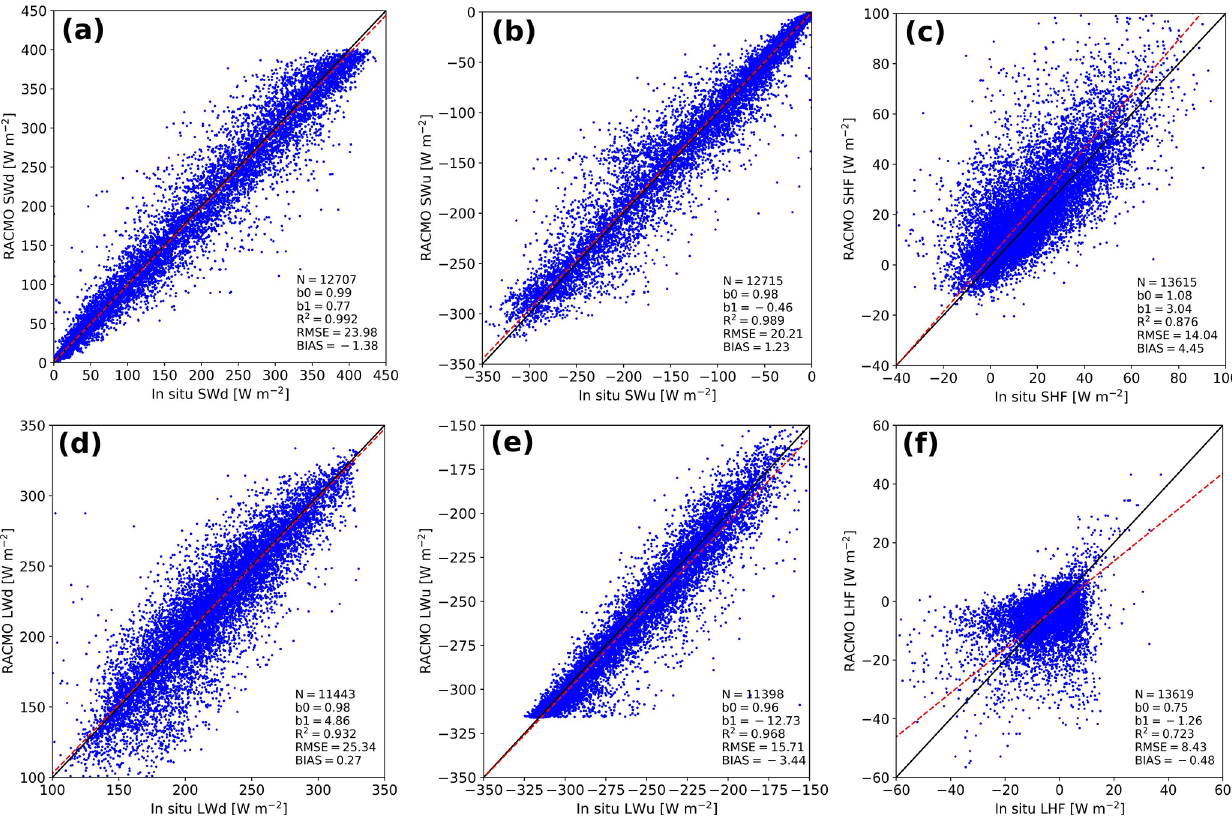
Figure 6. Daily-averaged Rp3 SEB components between 2006 and 2015 compared to in situ observations including S6, S9, and S10 of the K-transect and KAN-U and KAN-M of PROMICE for (a) downward shortwave radiation (SW d ), (b) upward shortwave radiation (SW u ), (c) sensible heat flux (SHF), (d) downward longwave radiation (LW d ), (e) upward longwave radiation (LW u ) and (f) latent heat flux (LHF). The black line is the one-to-one line, and the red line shows the orthogonal total least-squares regression of the data, with b0 the slope and b1 the intercept. Number of records ( N ), determination coefficient ( R 2 ), root-mean-square error (RMSE, in Wm − 2 ), and bias (in Wm − 2 ) are also displayed. In all panels, positive values imply an energy flux directed towards the